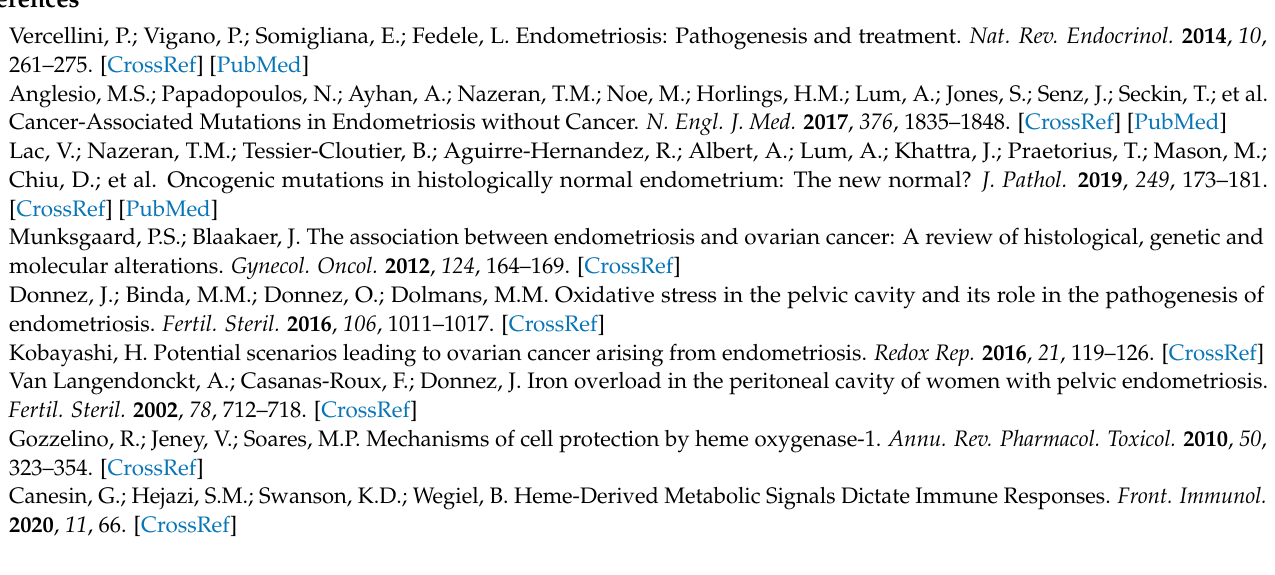
chemistry; Table S2: Correlation (r2 and p values) between the staining intensities in patients with EAOC. n = 17 patients. S-stroma; T-tumor; Hx-hemopexin, HO-1-heme oxygenase-1. Supplementary File S1 (original